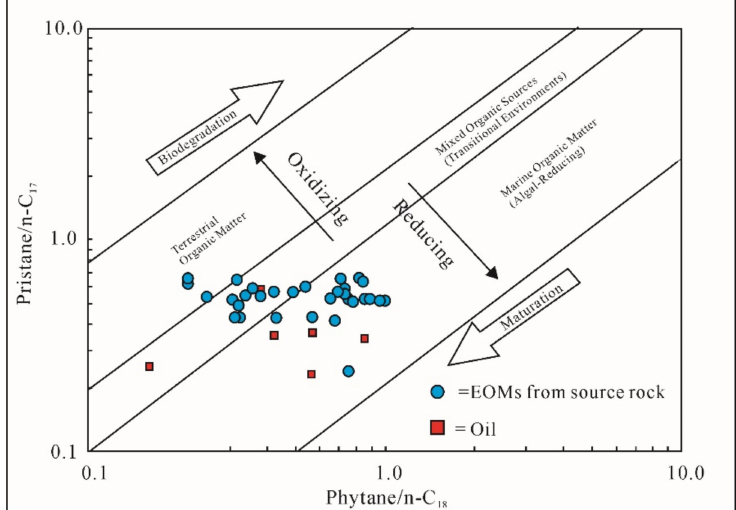
Figure 7. Cross-correlation of Pr/n-C17 and Ph/n-C18